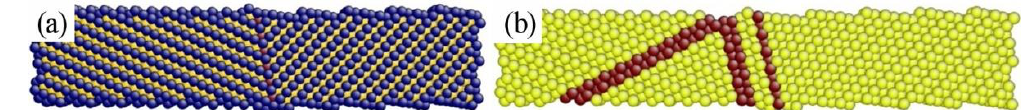
Figure 11. Atomic configuration of the simulation cell at ( a ) point A and ( b ) point B in Figure 10c.